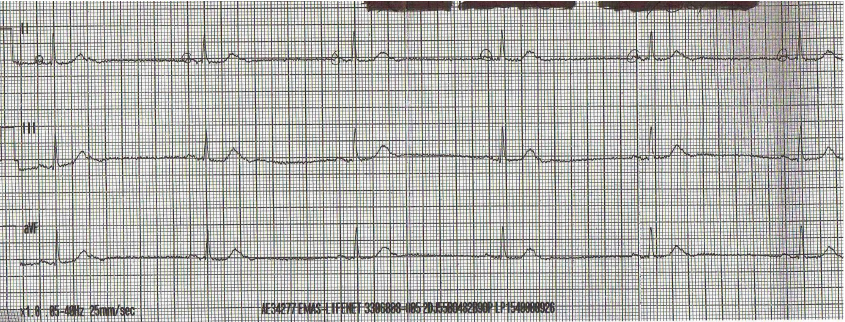
Figure 1: ECG showing sinus bradycardia.